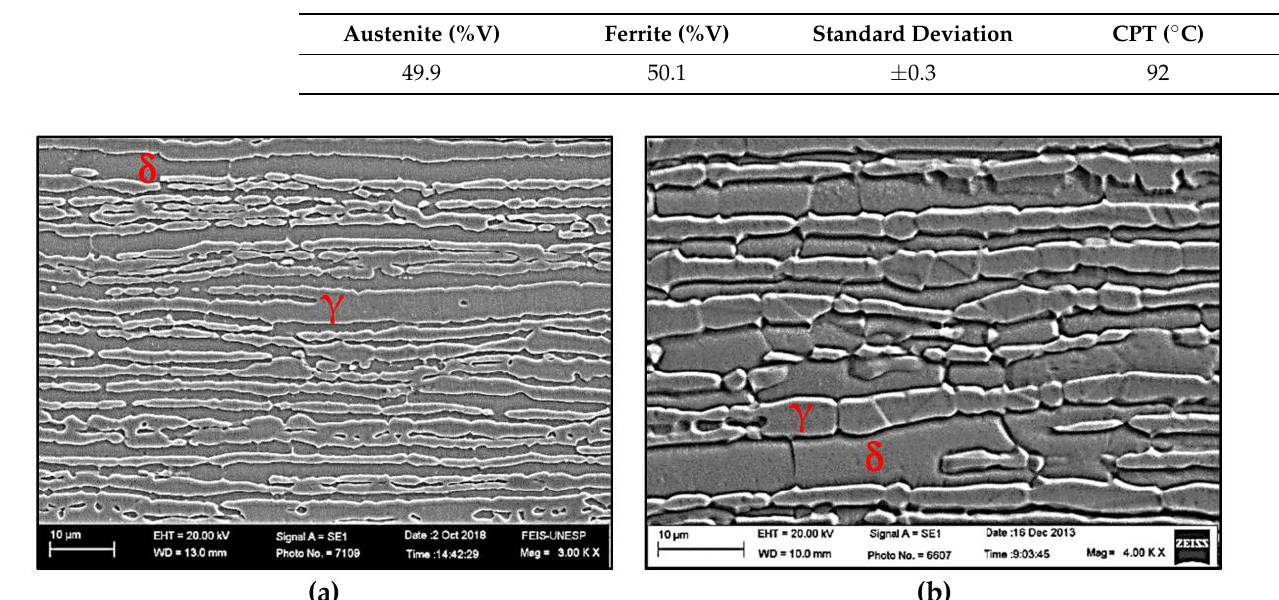
Figure 4. SEM pictures of the base material as received. ( a ) Reveals a balanced austenite/ferrite microstructure, with elongated geometry due to the lamination process; ( b ) Detail of austenite in high relief and ferrite in low relief due to Beraha etching.